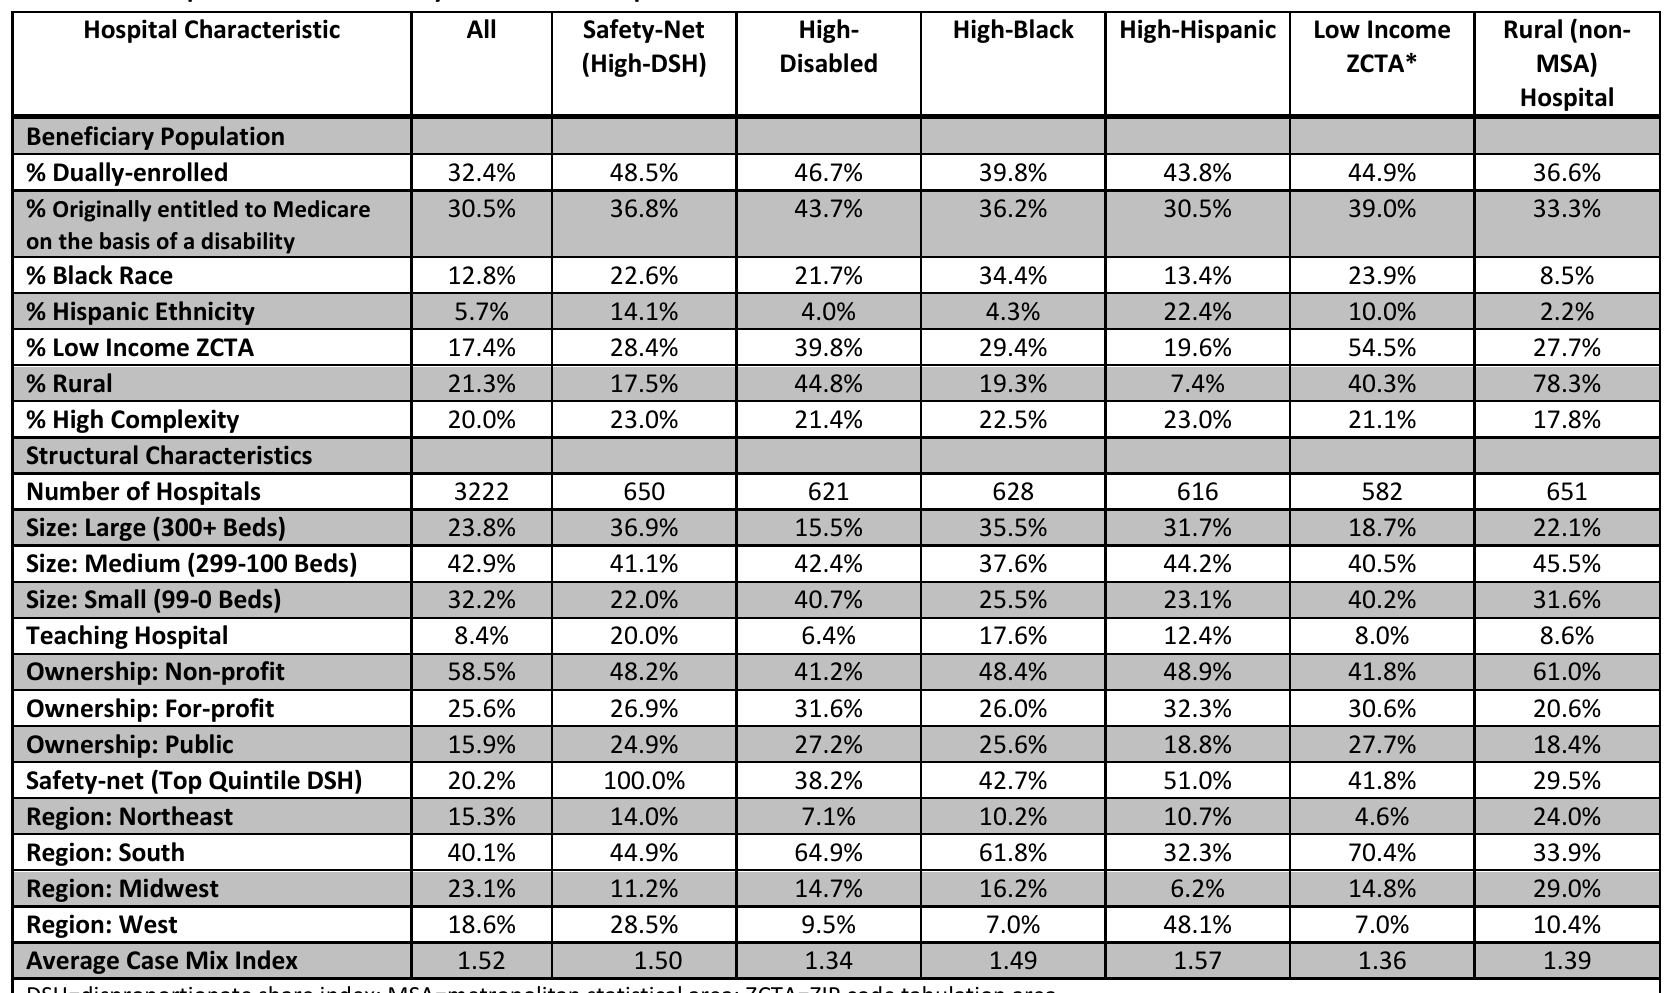
Table 6.4: Hospital Characteristics by Social Risk